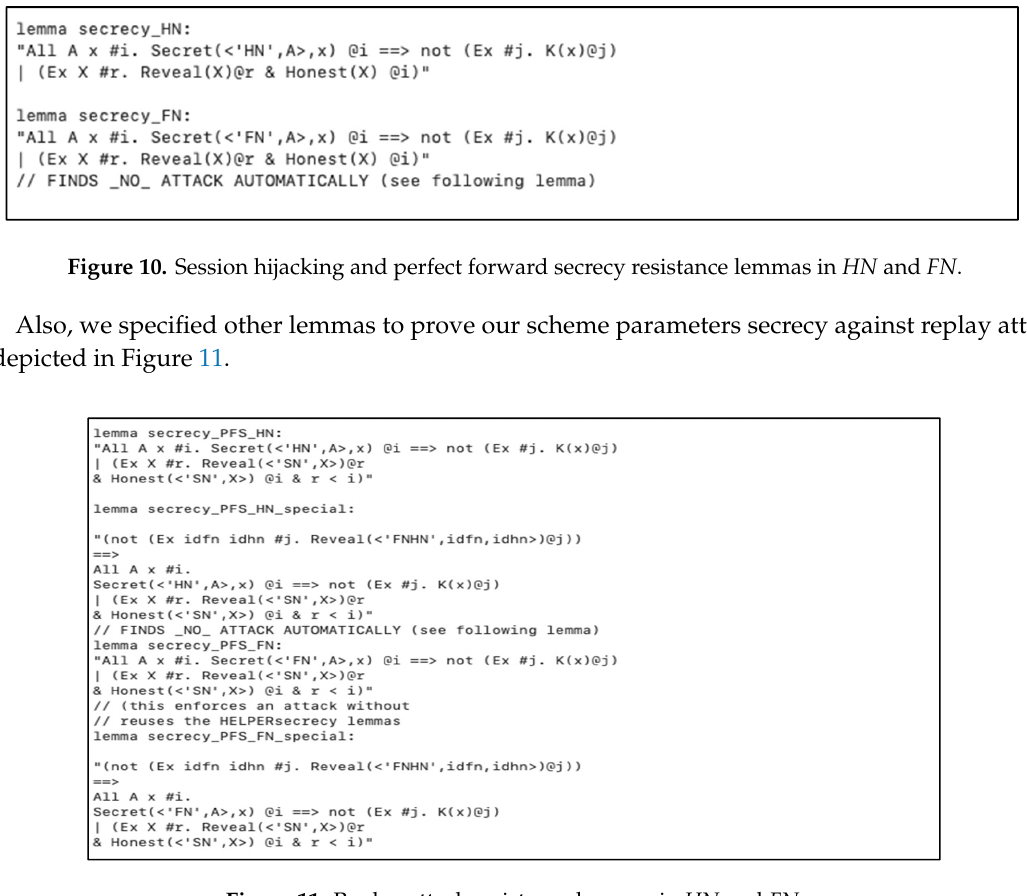
Figure 12. Replay attack resistance in FN .